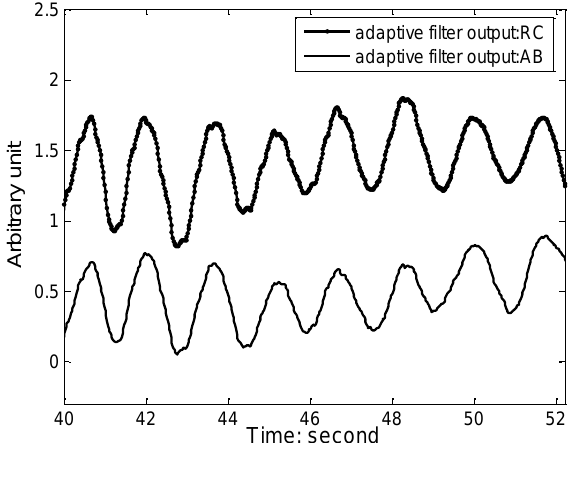
Figure 9. Output of adaptive filtering using least mean square (LMS) algorithm with accelerometer signal as